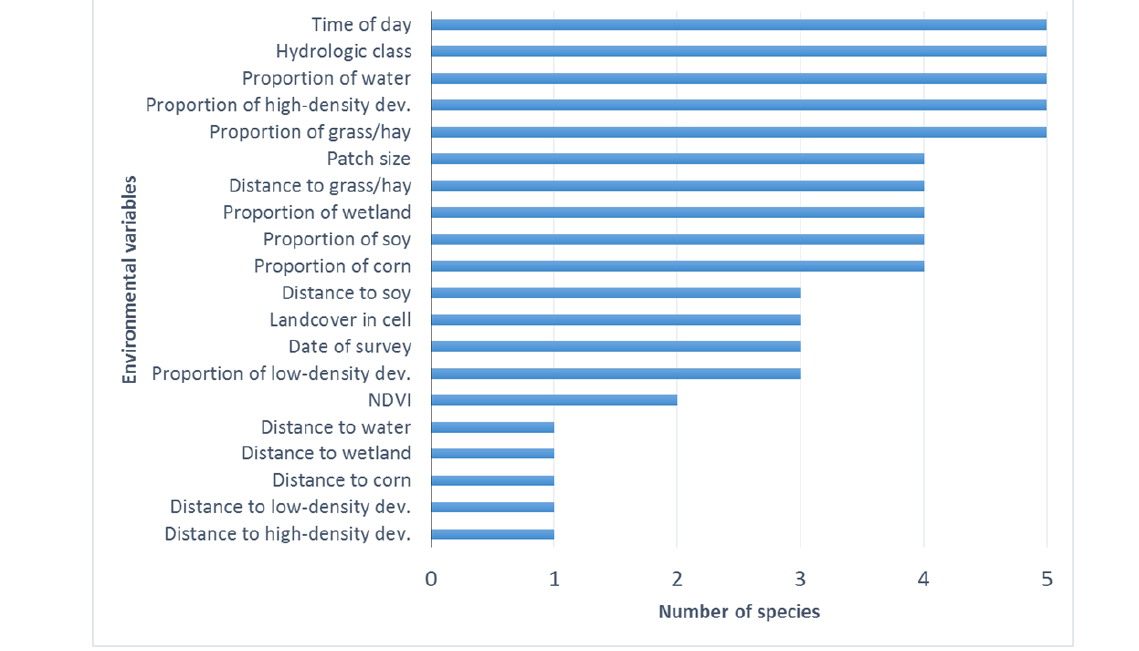
Table A1.1. Top five predictor variables for each species based on permutation-based variable